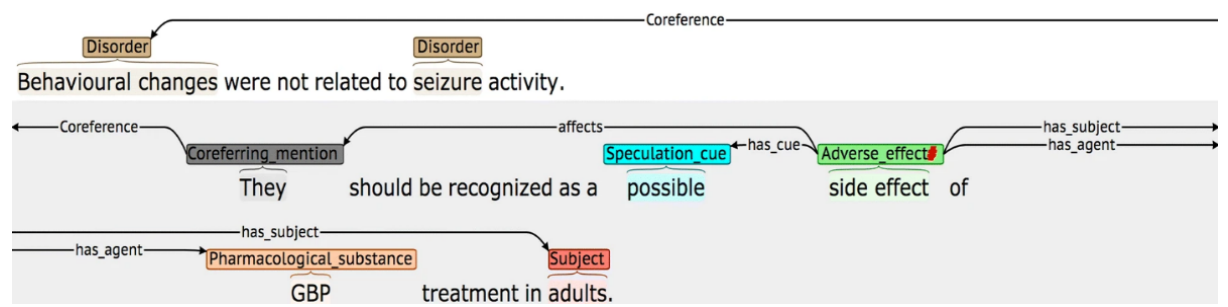
Figure 2. Information extraction pipeline annotation result